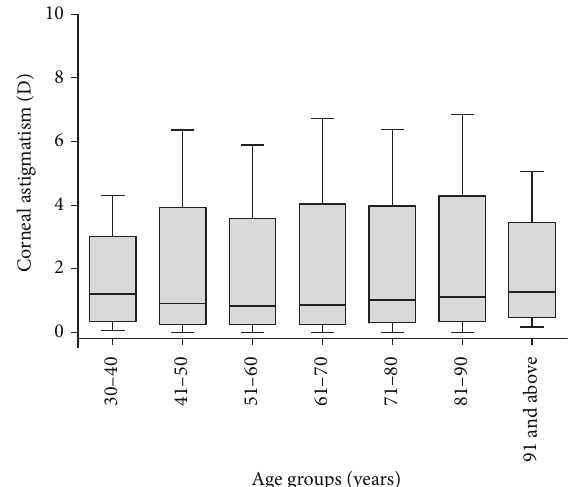
Figure 2: Corneal cylinder in all 7 age groups. The bold lines in the boxes represent the median (50% percentile), the upper and lower limits of the box represent the first quartile (25% percentile) and third quartile (75% percentile), and the bars represent the minimum and maximum